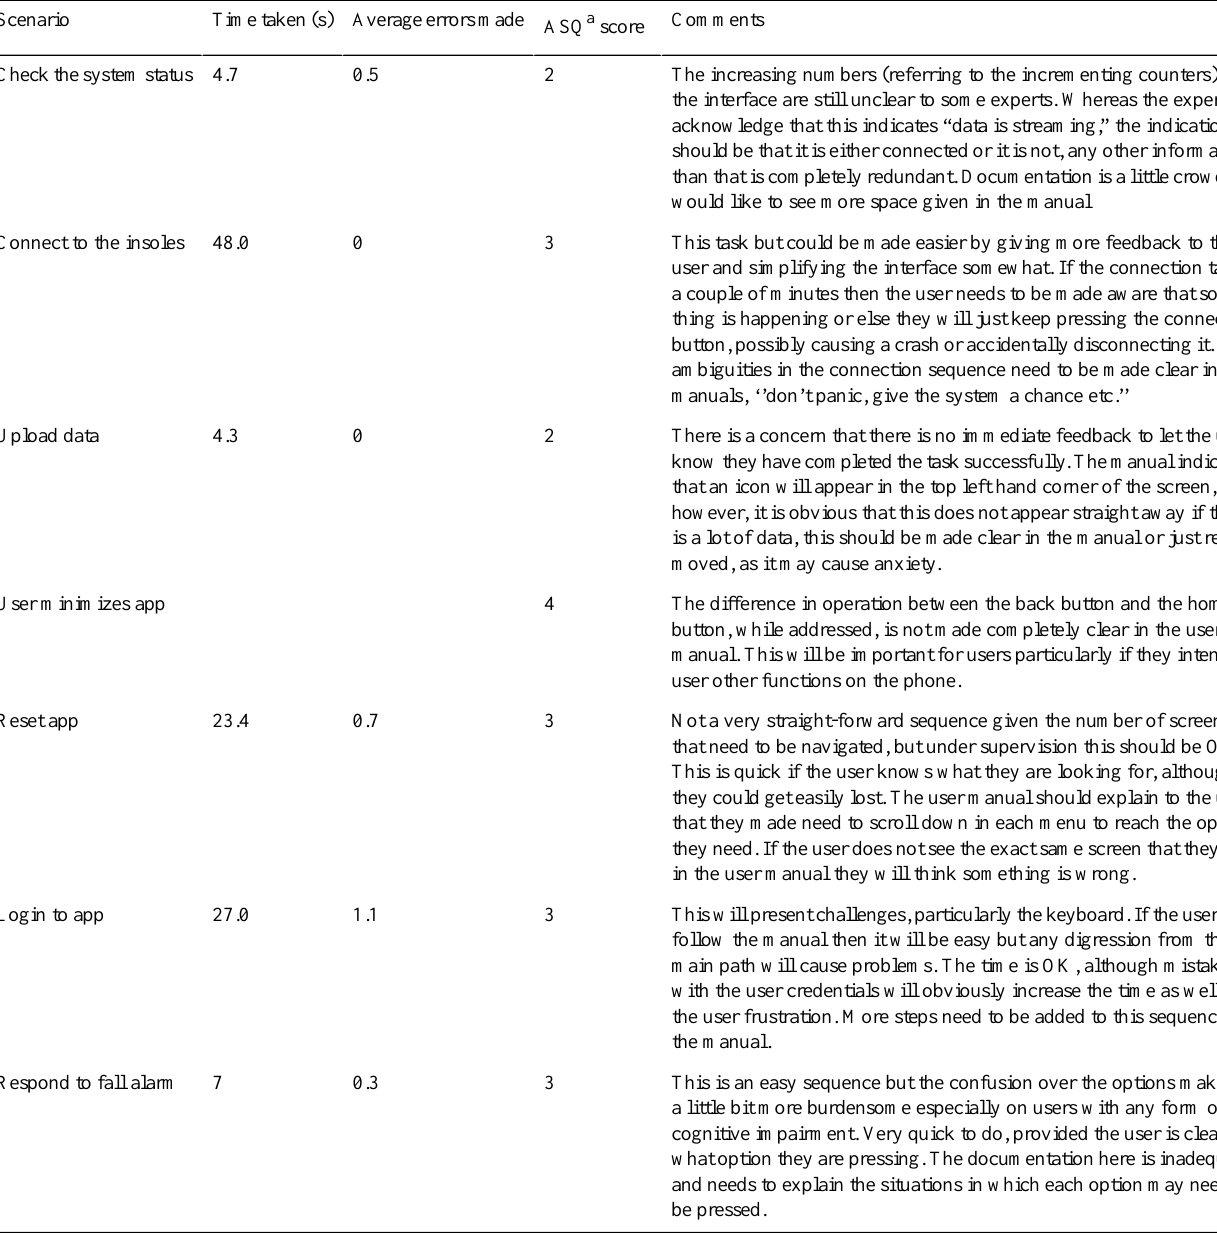
Table 11. Average metrics and consensus for 9 experts. After scenario questionnaire (ASQ) scores range from 1-7, where 1 is the most satisfied and 7 is the least satisfied the user can